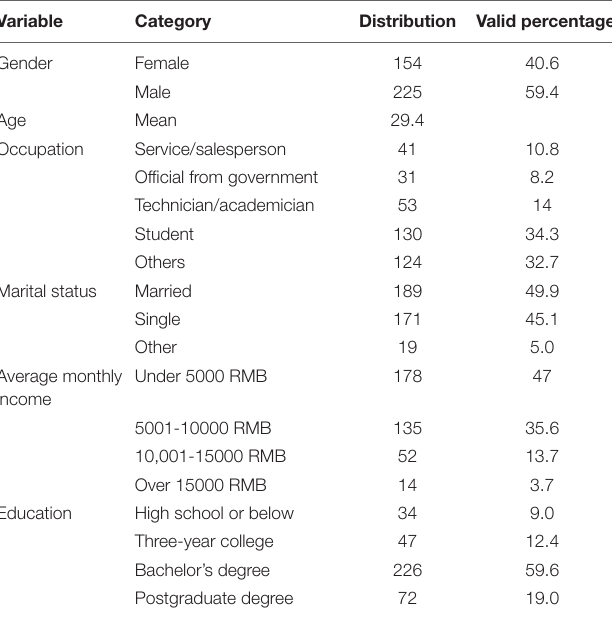
TABLE 1 | Demographic characteristics of the